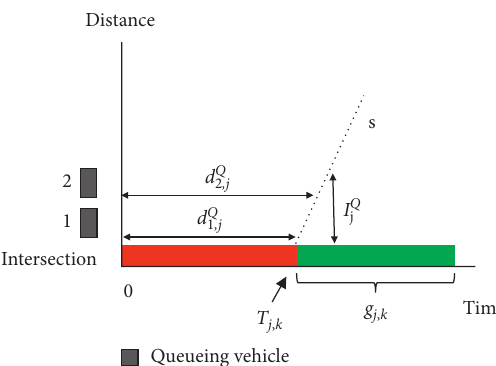
Figure 5: Delay of queueing